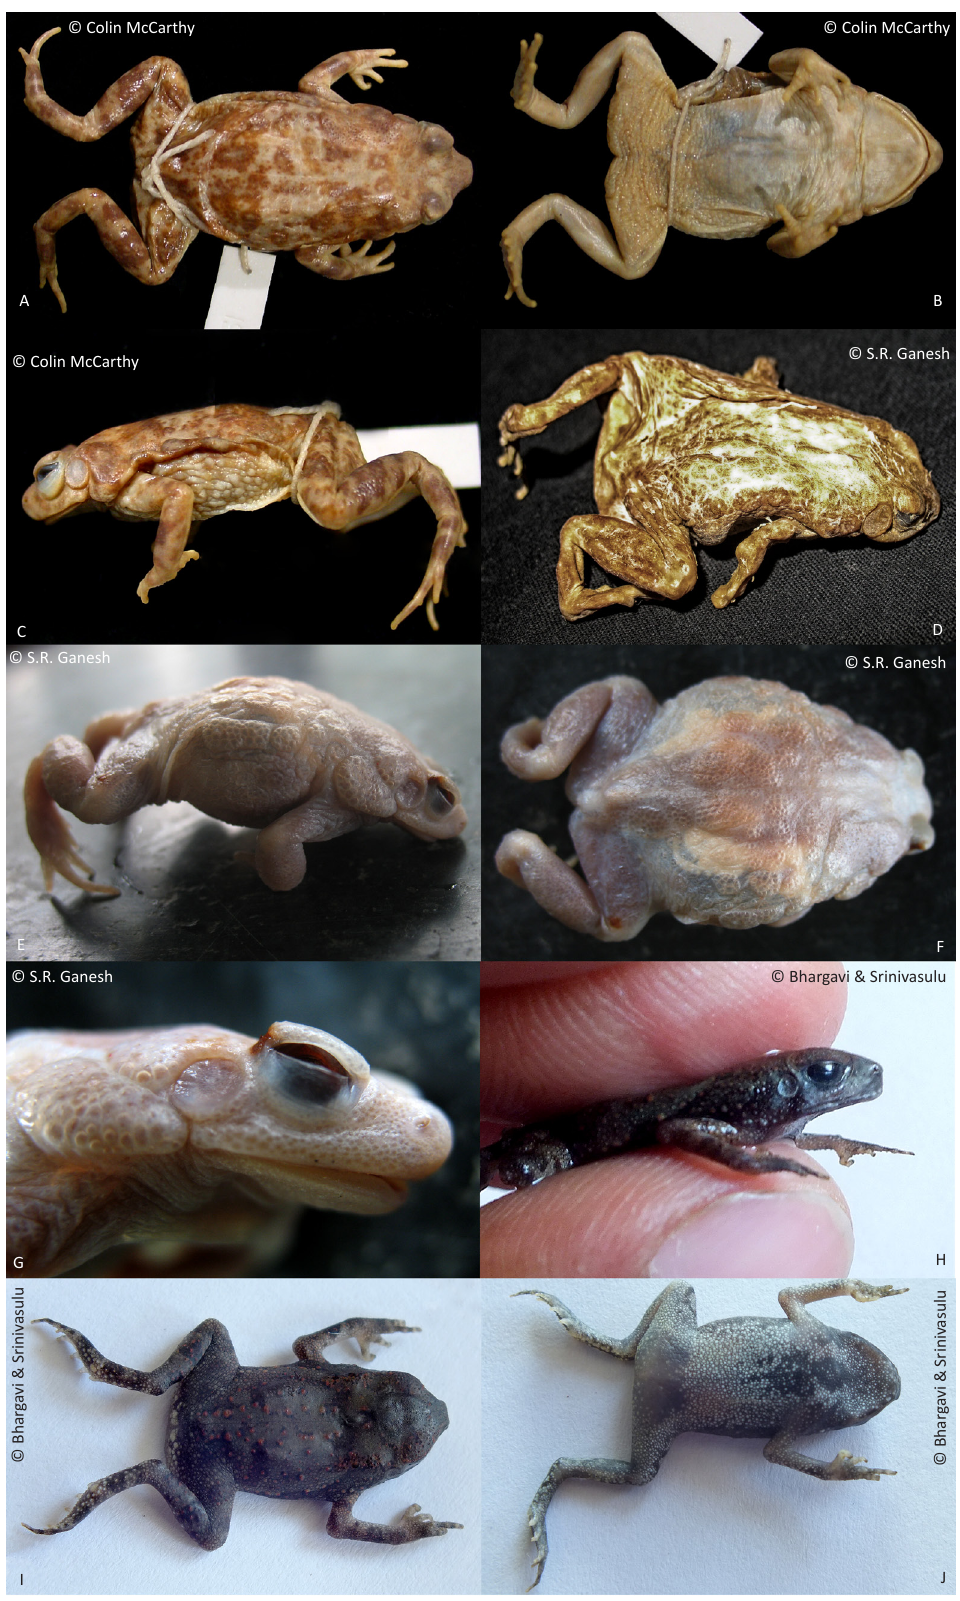
Image 1. Günther’s Toad Duttaphrynus hololius (top left to bottom right): A–C - Holotype BMNH 1947.2.20.50); D–G - historical nontypes MAD unreg. & ZSIM A361; H–J - Visakhapatnam specimen